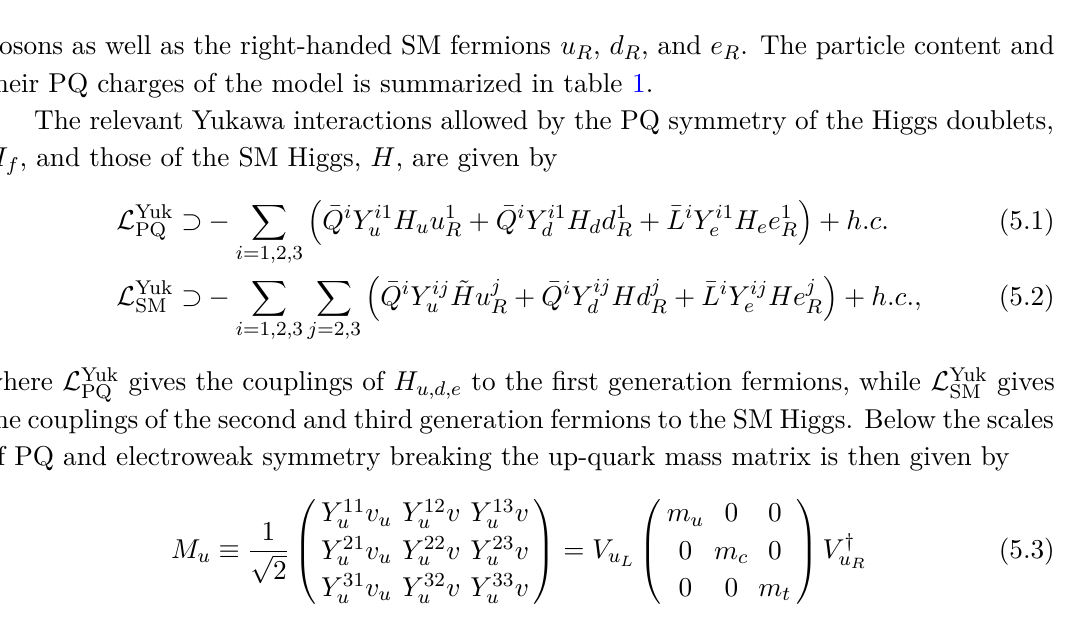
Table 1 . SU(2) L × U(1) Y × U(1) PQ charges of the SM Higgs, additional Higgs doublets H f , right- handed fermions, and Higgs singlets φ f , where U(1) PQ is a global Peccei-Quinn-like symmetry and f = u, d, e . The PQ charges are Q u = 2 , Q d = 1 and Q e = 1 /n , with n = 2 or 3 . All other particles are considered to be PQ